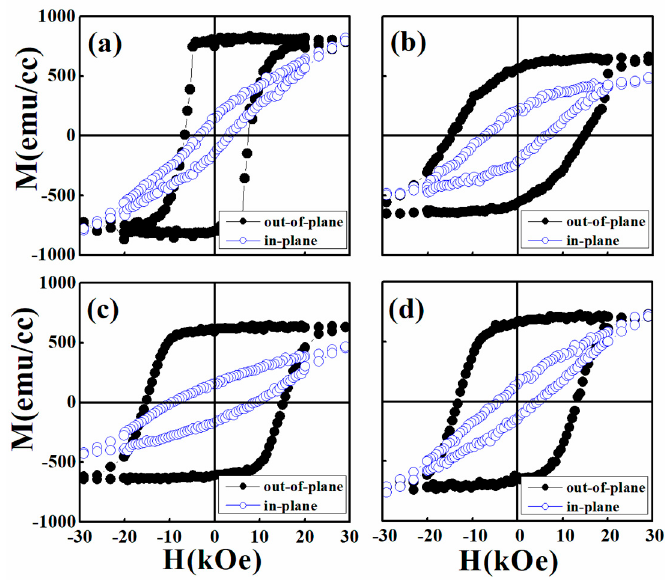
Figure 2. Magnetic hysteresis loops of the FePt(BN, Ag, C)( x vol.%)/MoC( y nm)/MgTiON/CrRu/glass films, ( x , y ) = ( a ) (0, 0), ( b ) (10, 0), ( c ) (0, 3), ( d ) (10, 3).